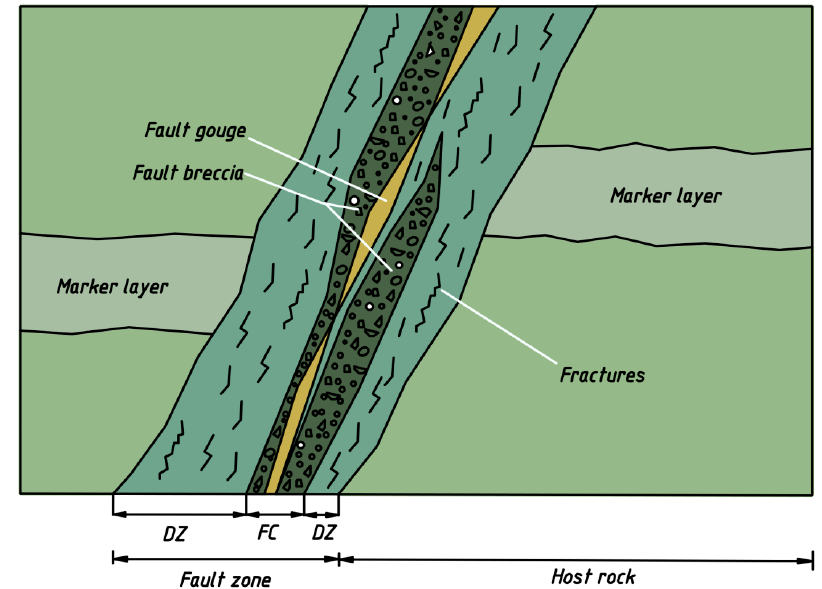
Figure 1. Typical structural elements of a fault zone. Generally, it consists of two parts: damage zone (DZ) and fault core (FC); fault gouge and fault breccia are structure elements within the fault core and sets of fractures are subsidiary structures in damage zones. Modified from Gudmundsson [23].